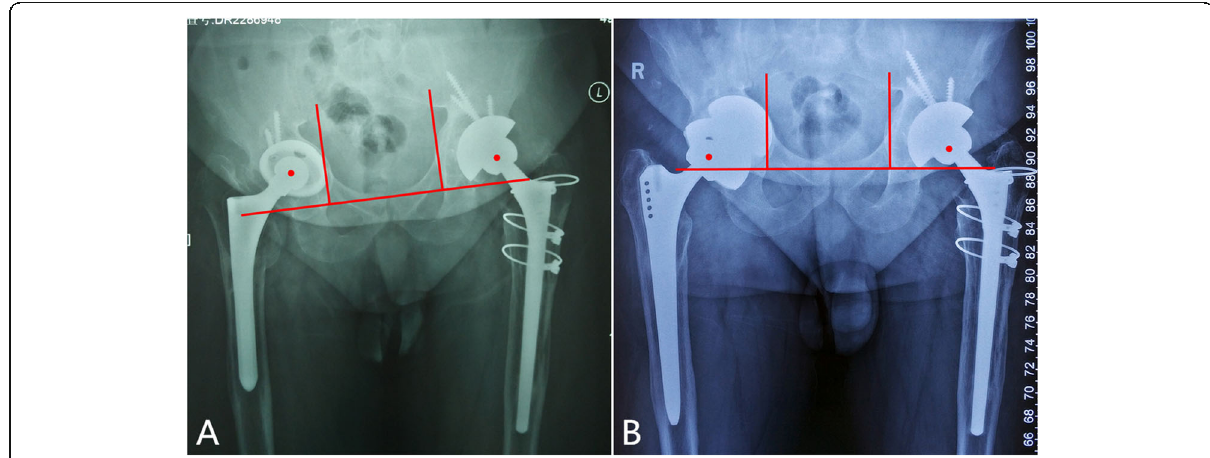
Fig. 2 A 51-year-old male patient who had previous failure of a total hip arthroplasty. A A Paprosky IIC defect on the right hip. B The “ cup-on- cup ” reconstruction technique was performed with 2 tantalum TM shells. The larger tantalum cup was impacted onto the medial TM revision shell and a rigid fixation was achieved based on the lateral acetabular rim (out diameters of the shell from medial to lateral: 52 mm and 58